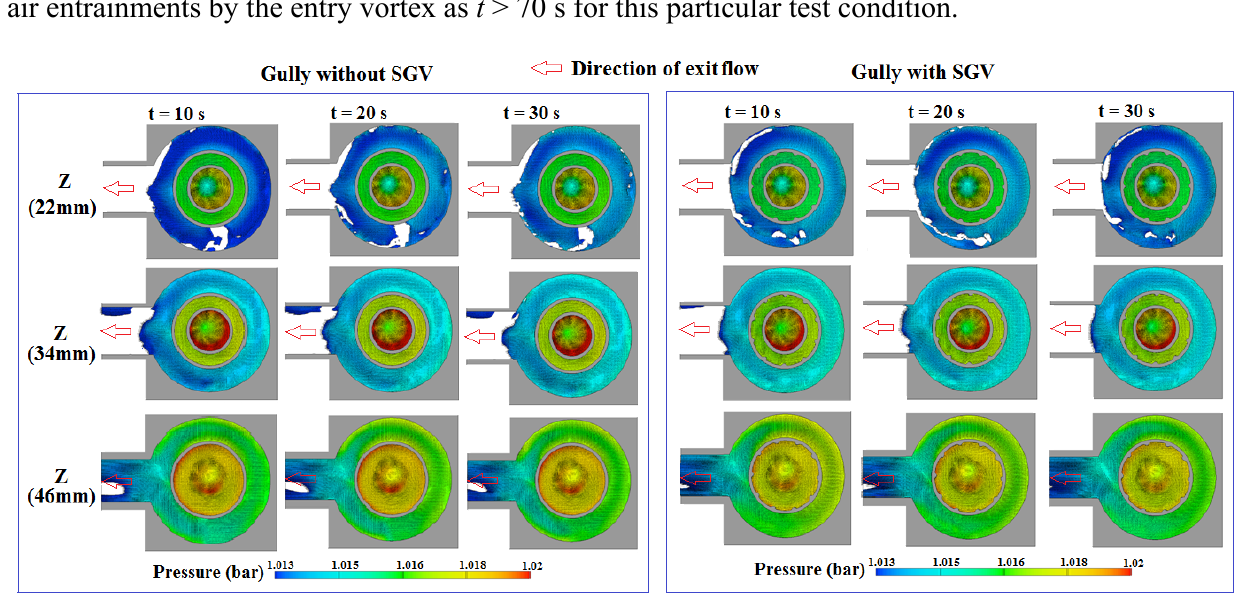
Figure 5. Distributions of instant velocity and pressure contour for gullies with/without SGV over horizontal XY planes at Z = 22, 34, 46